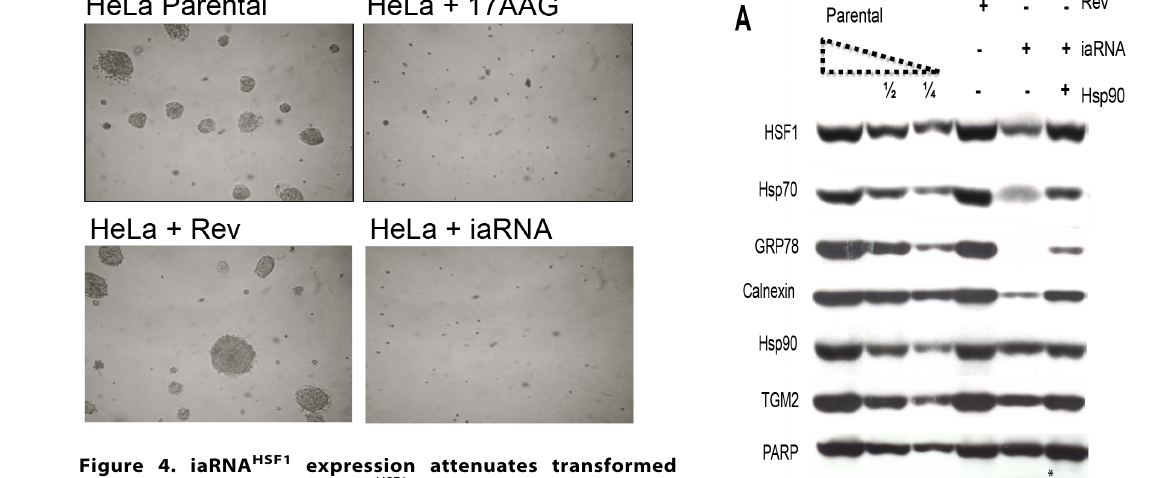
Figure 4. iaRNA HSF1 expression attenuates transformed growth. HSF1 inhibition by iaRNA HSF1 inhibits transformed growth in soft agar. Soft agar analysis of non-transfected HeLa cells (top left) or control RNA over-expressing HeLa (bottom left), shows that iaRNA HSF1 over-expression (bottom right) inhibits cellular transformation (colony formation) in a similar manner as treatment of HeLa cells with 150 nM 17-AAG (top right) (Day 14).